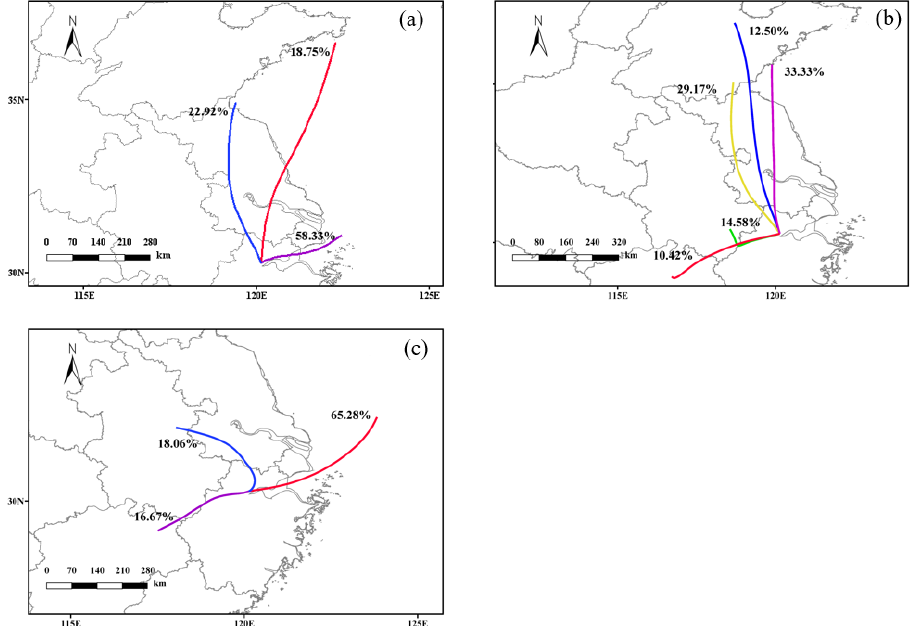
Figure 4. Clustered trajectories (%) from different directions on different control phases (hase ( a ), phase ( b ) and phase ( c )) at the ZH site.